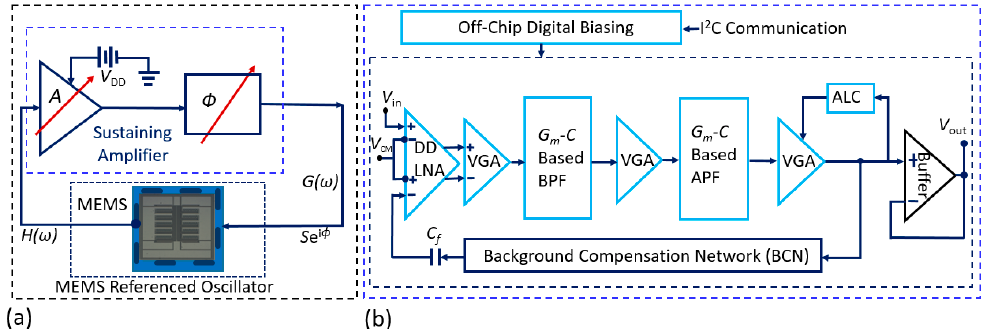
Figure 3. ( a ) Simplified system diagram illustrating the integration of the MEMS resonator chip with the CMOS sustaining amplifier chip; ( b ) Simplified block diagram of the programmable single-chip CMOS sustaining amplifier (corresponding to the same color-coded dashed-line box in ( a )).